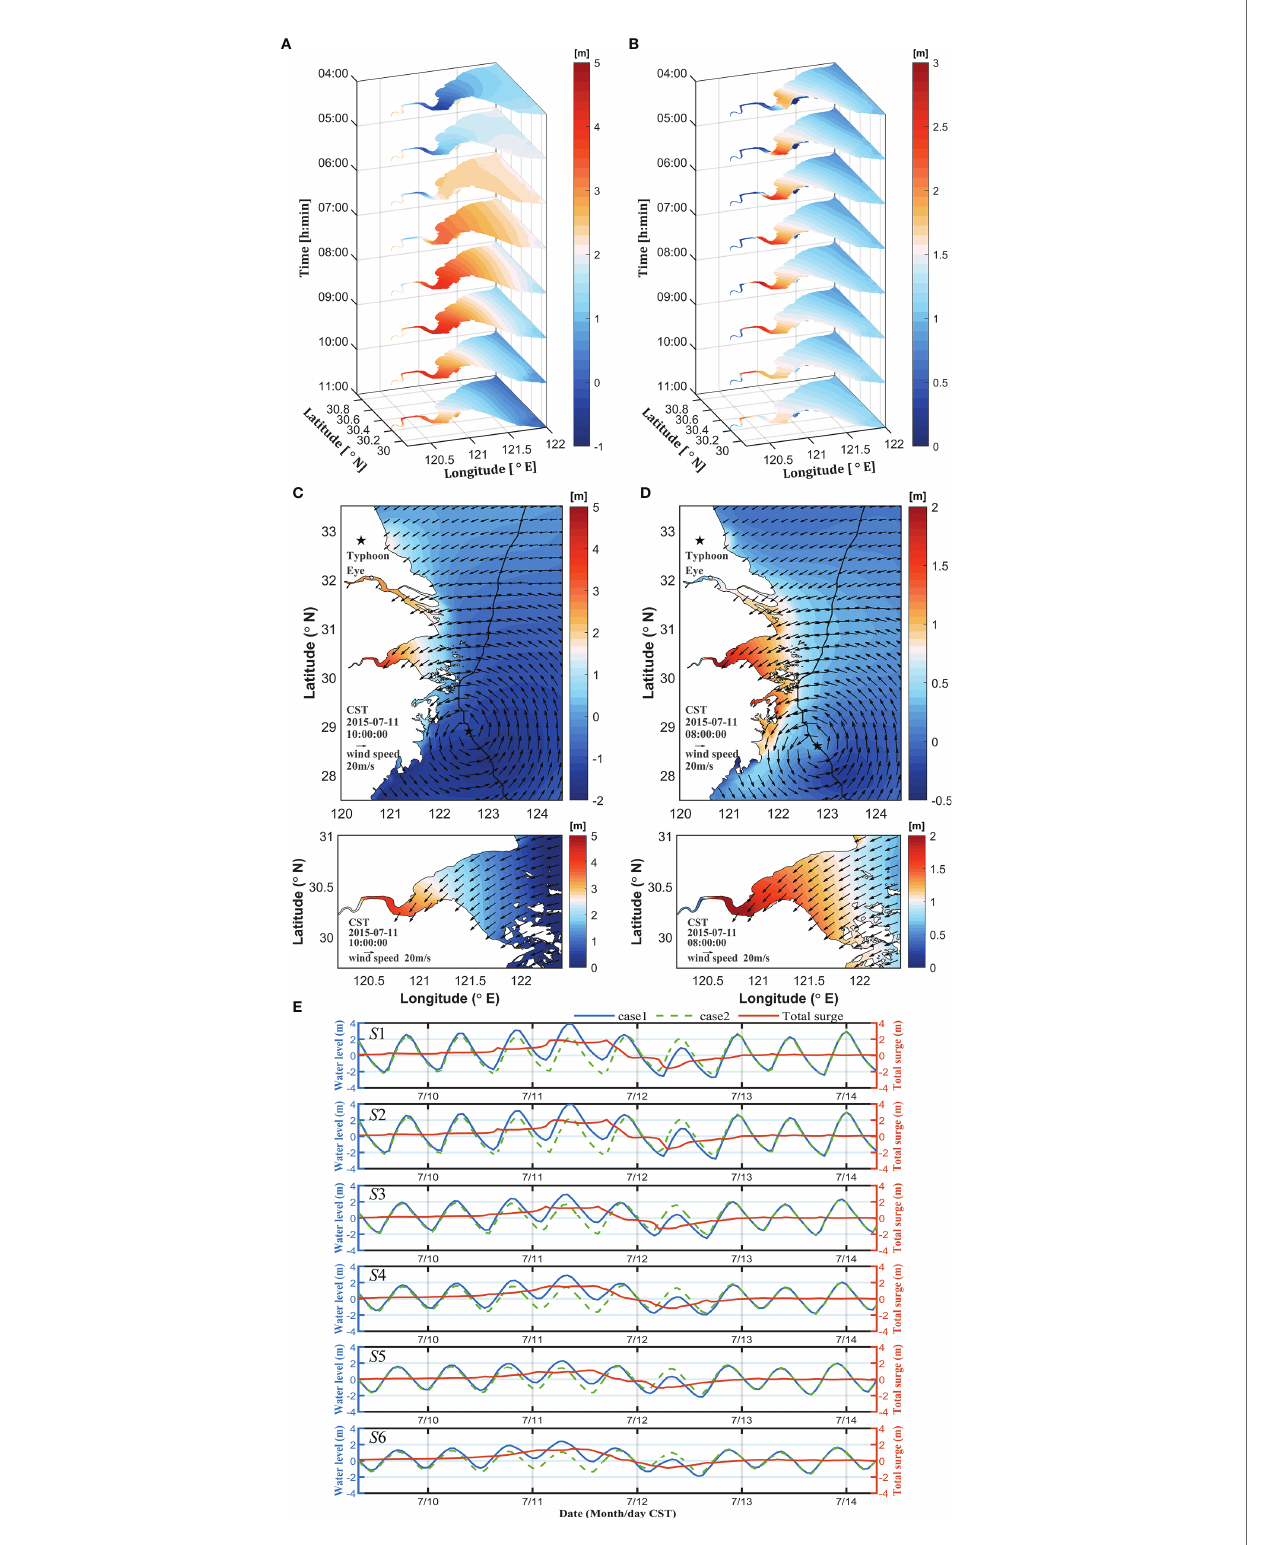
FIGURE 4 | Distribution of total water level and total surge during the typhoon from 04:00 to 11:00, July 11: (A) Total water level and (B) Total surge. (C) Sea surface level at 02:00, July 11. (D) Surges at 00:00 on July 11. (E) Sea surface level and total surge time series at each feature point (July 9-14). The green dashed line is the water level with only tidal forcing, blue solid line is the water level during the typhoon, and the orange line is the